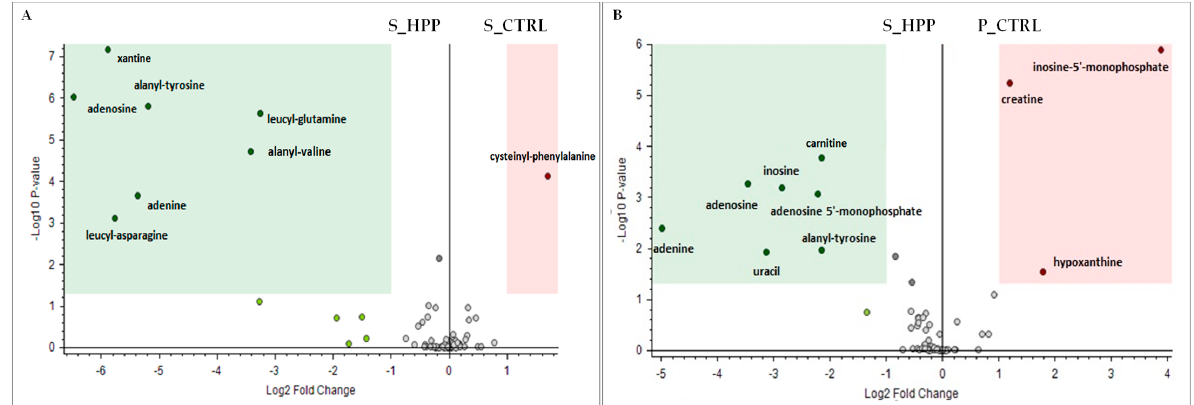
Figure 3. Volcano plot comparison between the relative intensity of chromatographic peak from salmon (S_CTRL and S_HPP; ( A )) and plaice (P_CTRL and P_HPP; ( B )) samples. The left region contains up-regulated signal with intensities from HPP-treated samples significantly higher than those from fresh samples and were greater than the upper fold-change (FC) threshold. The right region includes downregulated peaks where the intensities from HP treatment was significantly lower than those from fresh samples and was less than the lower FC threshold; ( p ≤ 0.05).